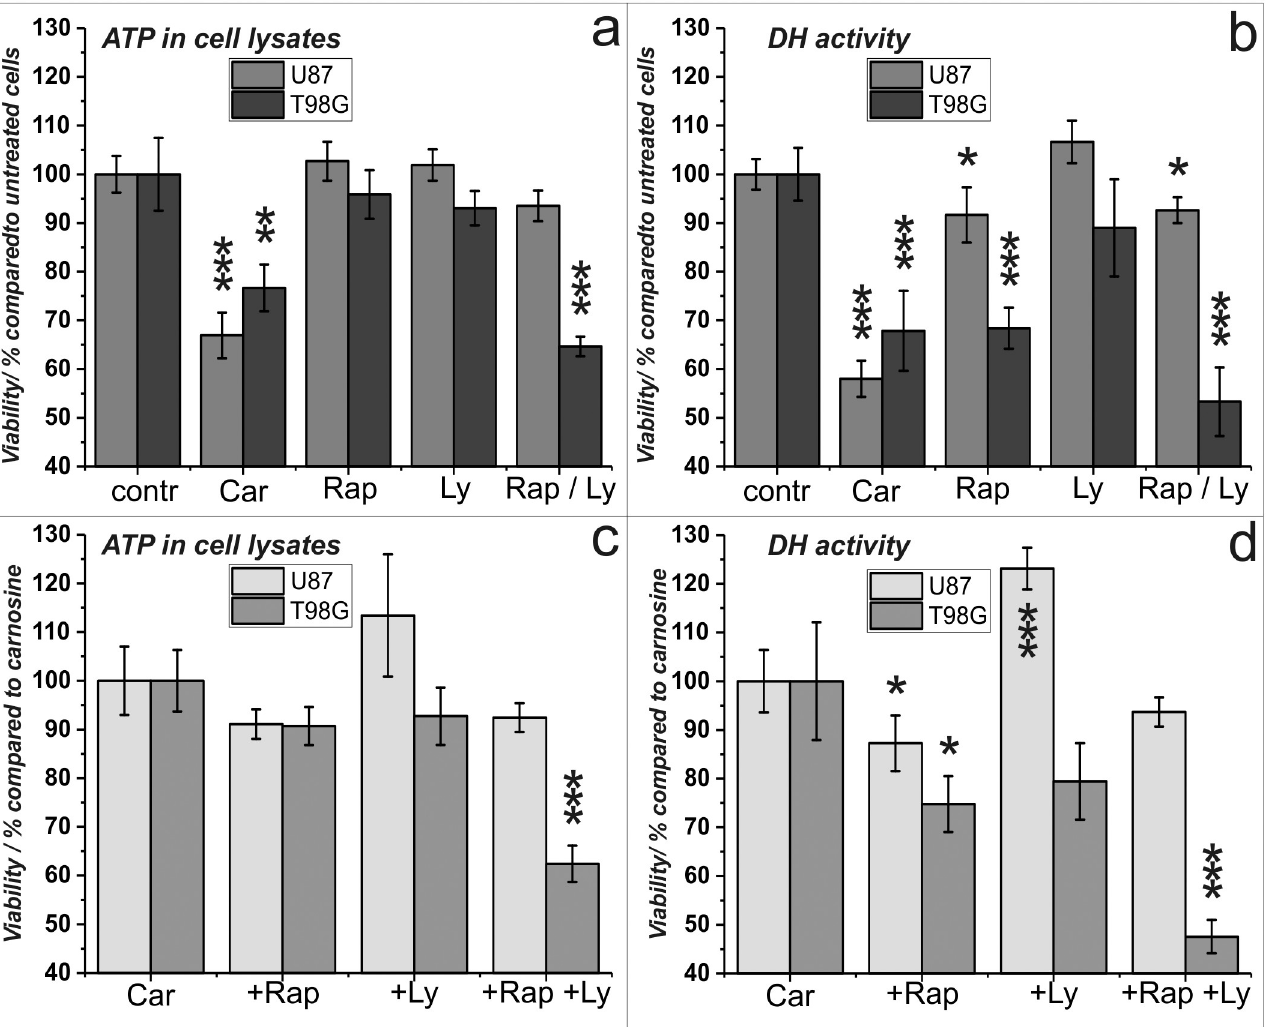
Fig 3. Viability of U87 and T89G cells under the influence of carnosine, rapamycin and Ly-294,002. Cells from the lines U87 and T98G were cultivated for 24 hours in the presence of carnosine (Car; 50 mM), rapamycin (Rap; 25 nM), Ly-294,002 (Ly; 5 μ M) or vehicle control (contr). Then, the amount of ATP in cell lysates (left panels) and dehydrogenase activities (right panels) as a measure of cell viability were determined. Upper panels show the influence of each compound on viability compared to untreated cells. In the lower panels the effect of rapamycin and Ly-294,002 on the viability of cells treated in combination with carnosine (cells treated with carnosine only set as 100%) is shown. Mean and standard deviation are presented from 8 independently treated wells for each condition. � : p < 0.05; �� : p < 0.005, and ��� : p < 0.0005.